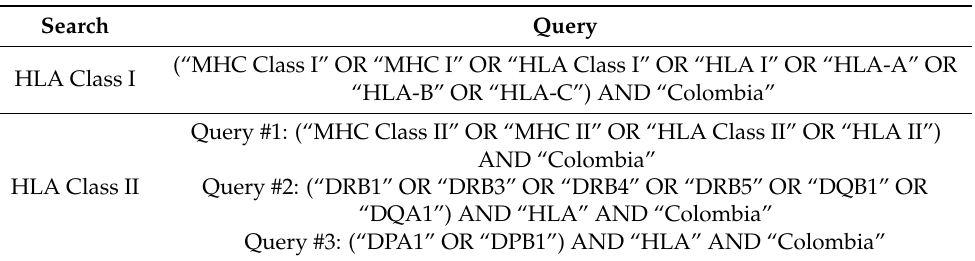
Table 1. Search queries used to identify allelic frequencies of HLA I and HLA II in the Colombian population on PubMed, Web of Science, and Science Direct (date consulted: 24 February